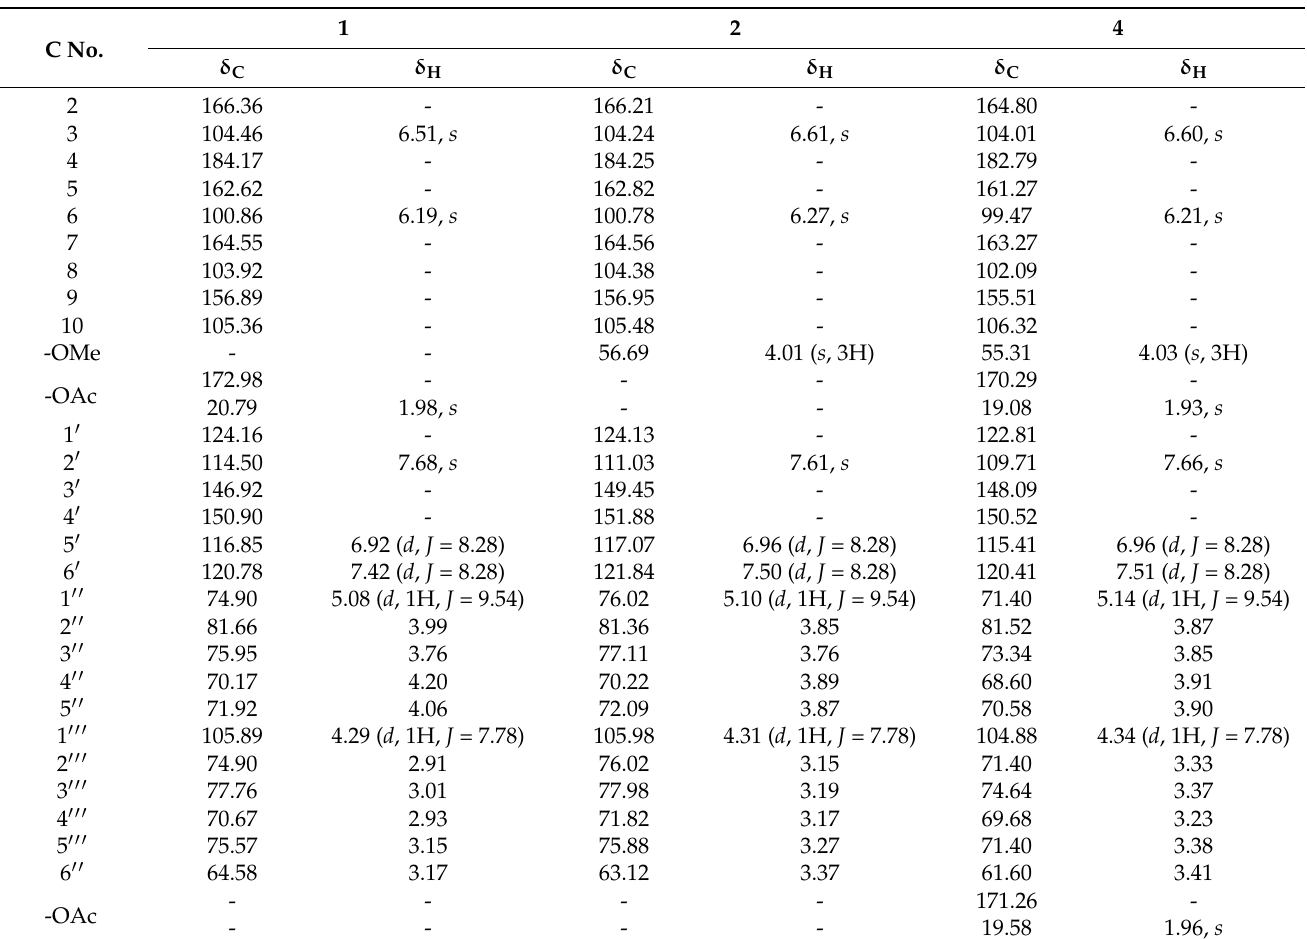
Table 1. 1 H and 13 C spectral data of 1 , 2 , and 4 (CD 3 OD, 400 Hz, δ in ppm, J in